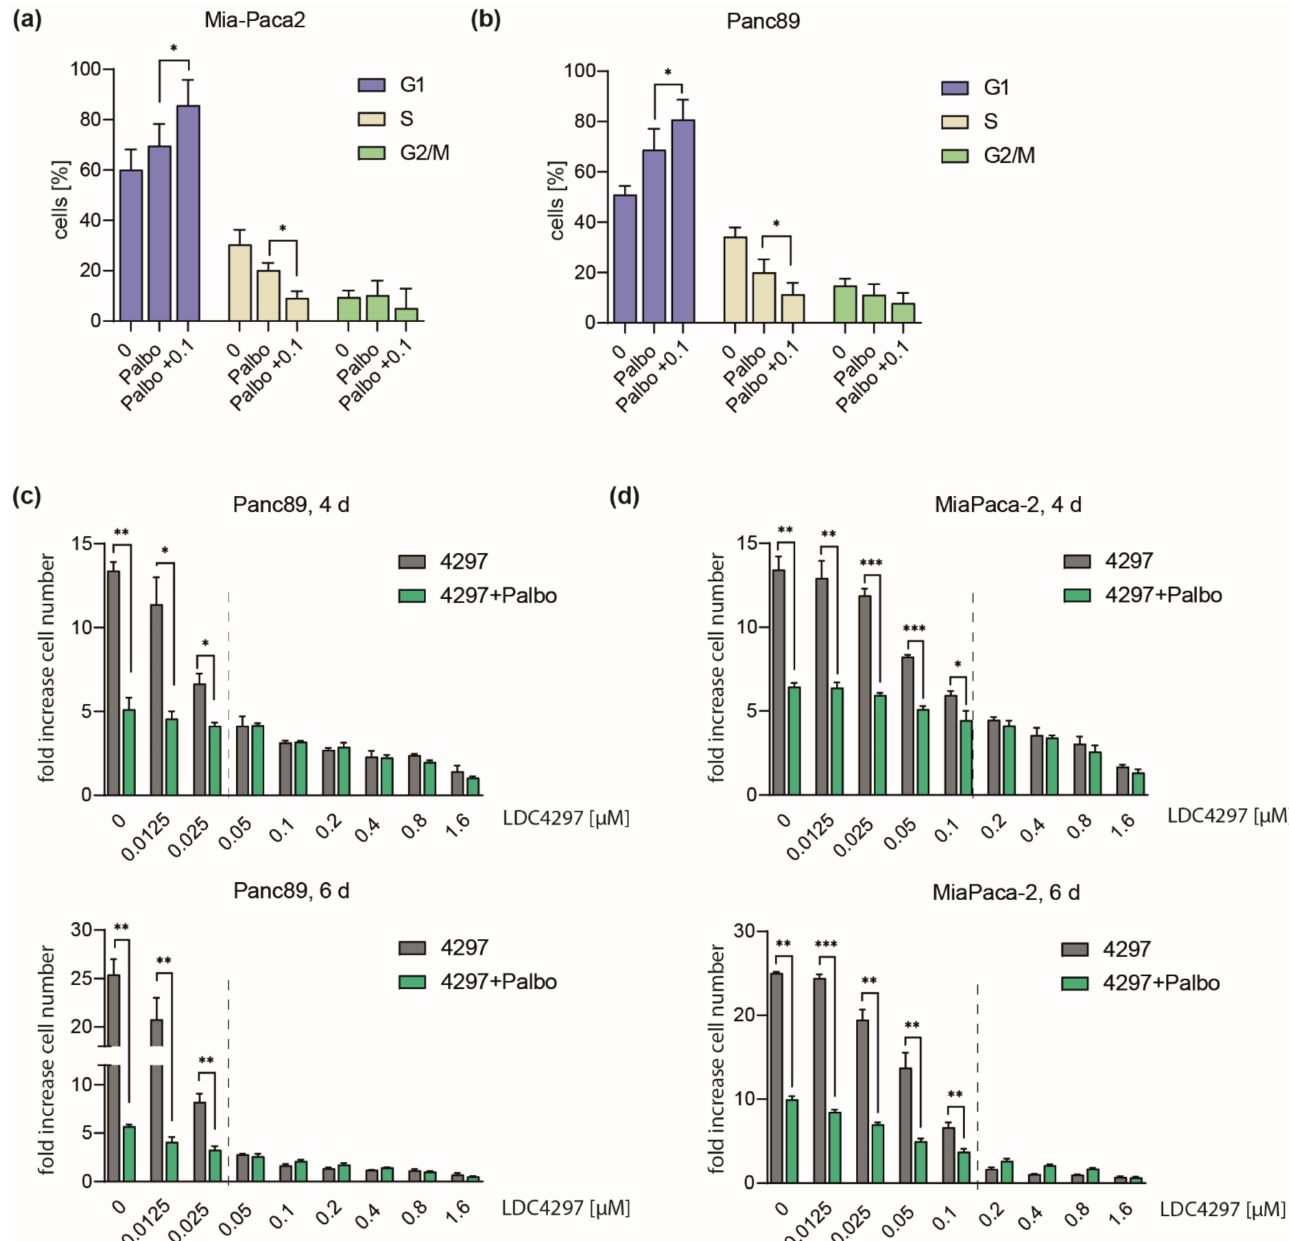
Figure 3. Concentration-dependent interplay of Palbociclib with LDC4297. ( a , b ) Mia-Paca2 and Panc89 cells were treated with 2 µ M Palbociclib in the absence or presence of 0.1 µ M LDC4297 for 4 days, DAPI stained and analyzed by FACS. Shown is the mean ± SD ( n = 4). ( c , d ) Panc89 and Mia-Paca2 cells were treated with the indicated concentrations of LDC4297 [ µ M] in the absence or presence of 2 µ M Palbociclib. Cell viability was analyzed after 4 and 6 days. Shown is the mean ± SD ( n = 3). Dashed line indicates the border of the (sub-)additivity range of CDK7 and CDK4 inhibitors. Significance was analyzed by two-sided Student’s t test: * p ≤ 0.05; ** p ≤ 0.01; *** p ≤